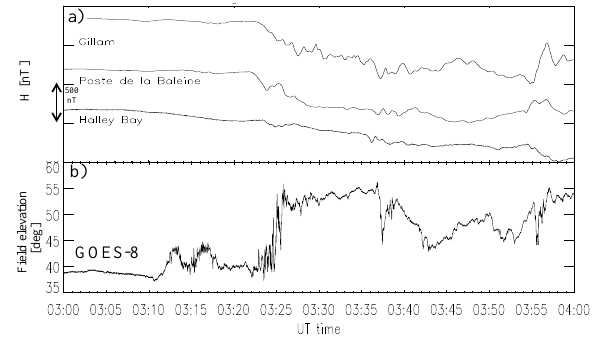
Fig. 4. Magnetic field measurements from different regimes, 24 July 1998. Panel ( a ) show magnetic H components from the ground stations Halley Bay, Poste de la Baleine and Gillam. Panel ( b ) show the magnetic field elevation measured in geosynchronous orbit by GOES-8 at 22:20 LT.